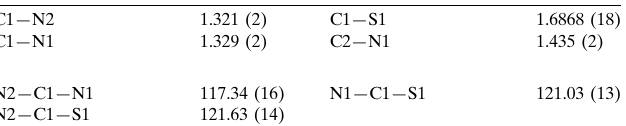
Selected geometric parameters (A˚ , (cid:1) ).